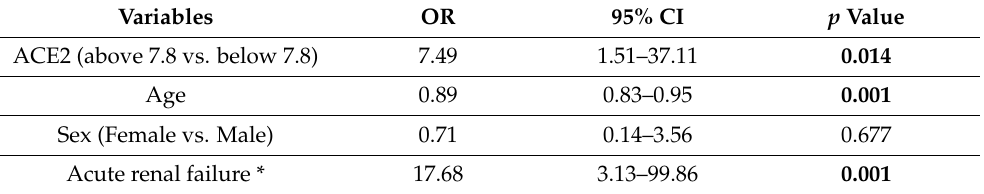
Table 3. ACE2 in early disease stages is an independent predictor of the need for mechanical ventilation. Variables OR 95% CI p Value ACE2 (above 7.8 vs. below 7.8) Sex (Female vs. Male) Acute renal failure